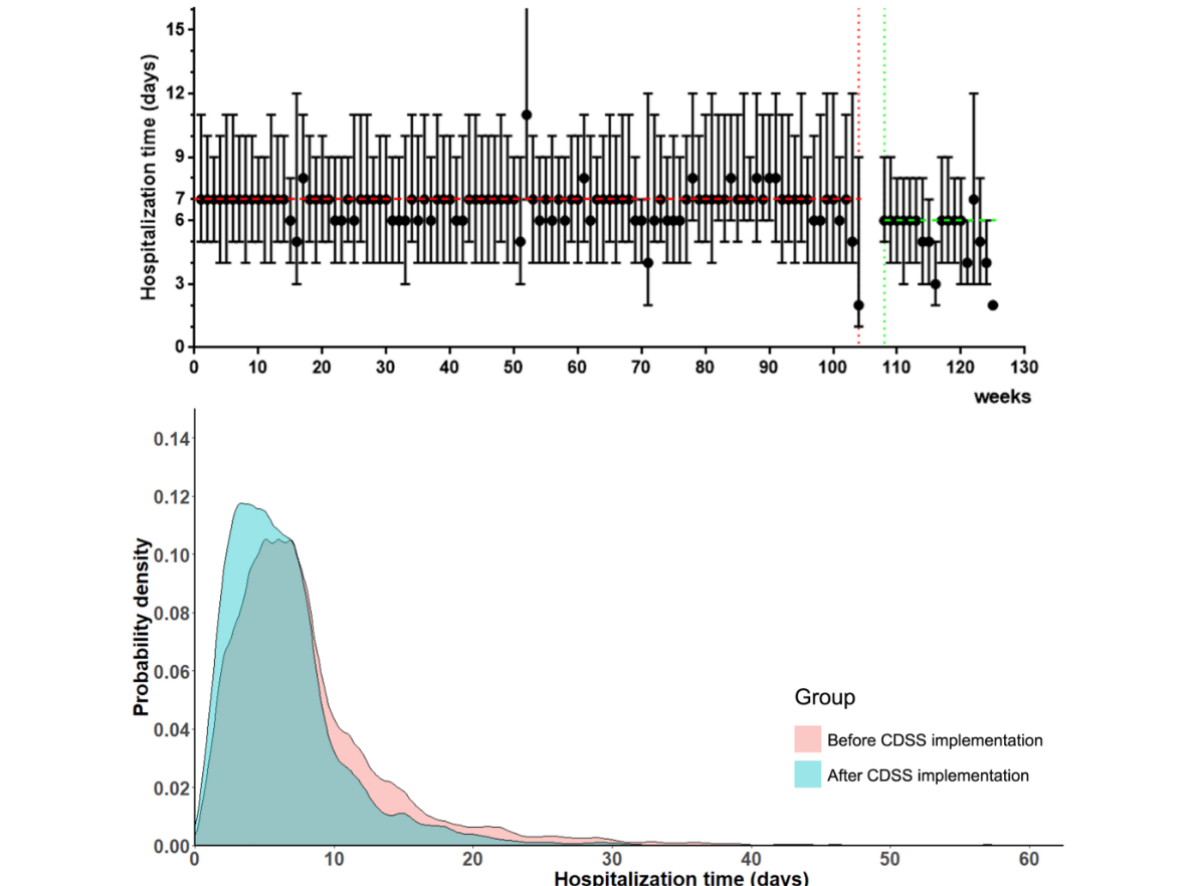
Figure 3. Box plot and probability density diagrams of hospitalization times before and after CDSS (clinical decision support systems) implementation. The red and green dotted lines, respectively, represent the median hospitalization days before and after CDSS implementation; the pink and blue shaded areas, respectively, represent the probability density before and after CDSS